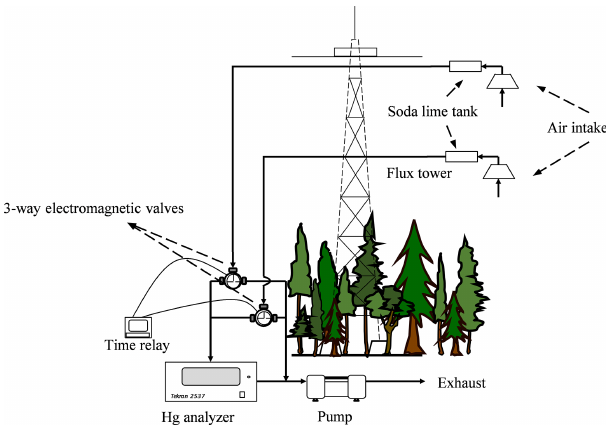
Figure 2. Apparatus used to monitor vertical concentration gradient of GEM above forest